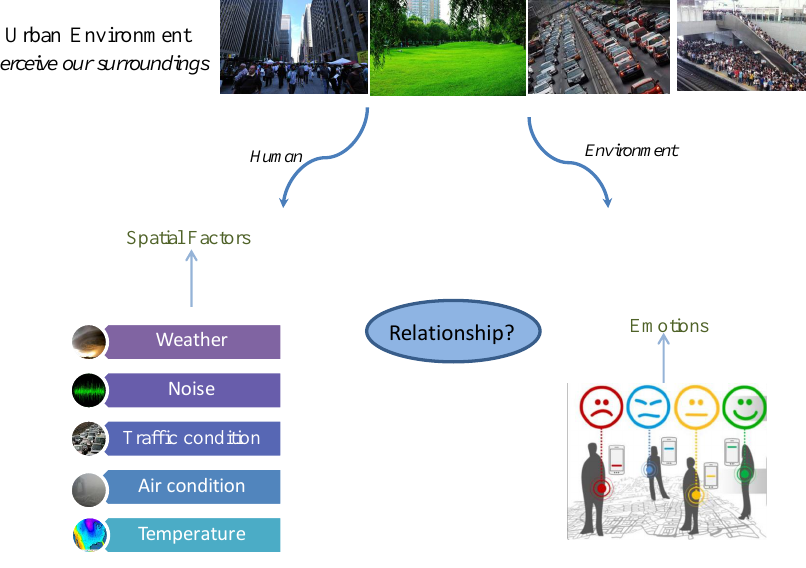
Figure 9. Multi-modal sensing for understanding human environmental